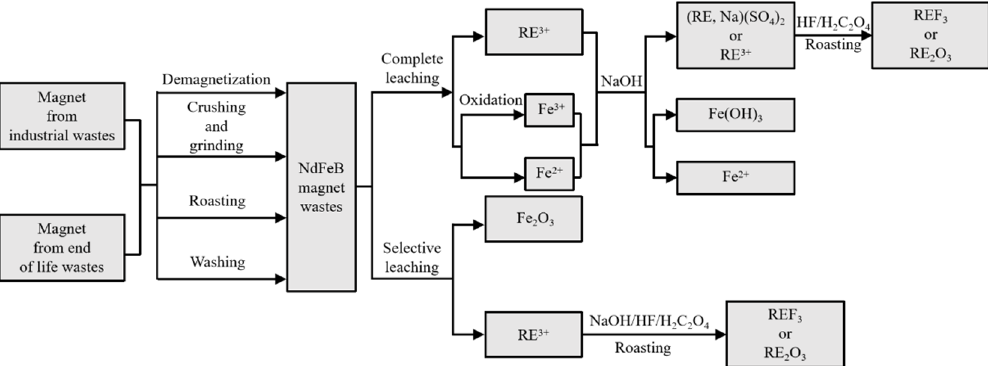
Figure 4. Flow chart of typical techniques for hydrometallurgy of NdFeB magnet